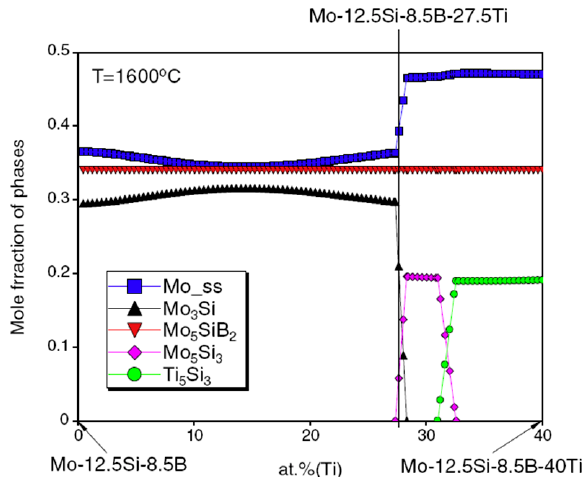
Figure 6. Calculated mole fractions of phases in (79 − x)Mo–xTi–12.5Si–8.5B (at.%) at 1600 °C as a function of Ti content [42].